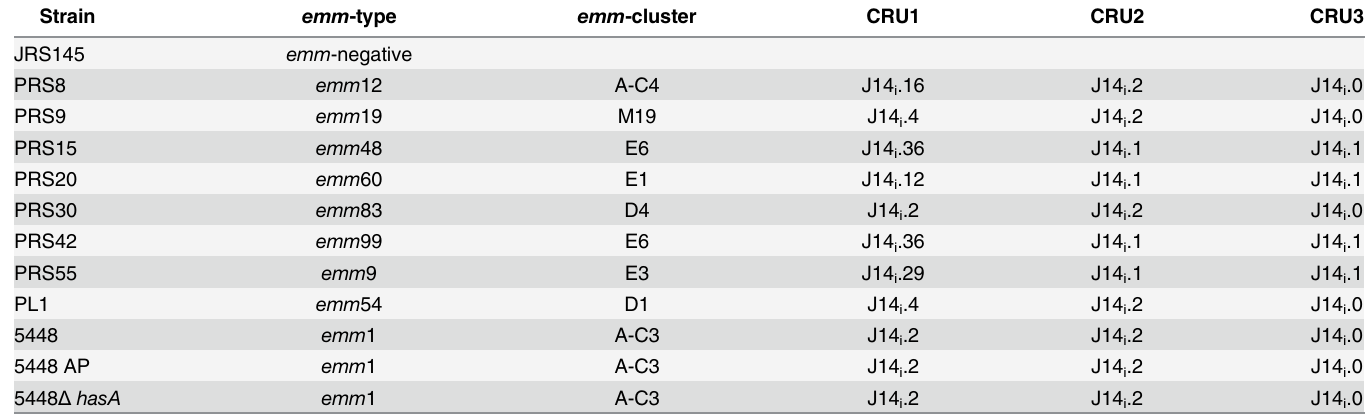
The GAS strains used in this study (Table 1) have all previously been described [20, 24, 25]. They represent 9 different emm-types, and one emm-negative strain. The strains also represent each of the major clusters proposed as part of the new emm-types clustering system [20]. All isolates were grown in sterile Todd Hewitt Broth supplemented with 1% neopeptone or on Columbia Blood agar containing 5% sterile horse blood. Recombinant proteins were expressed Table 1. GAS strains used in the study. Strain emm